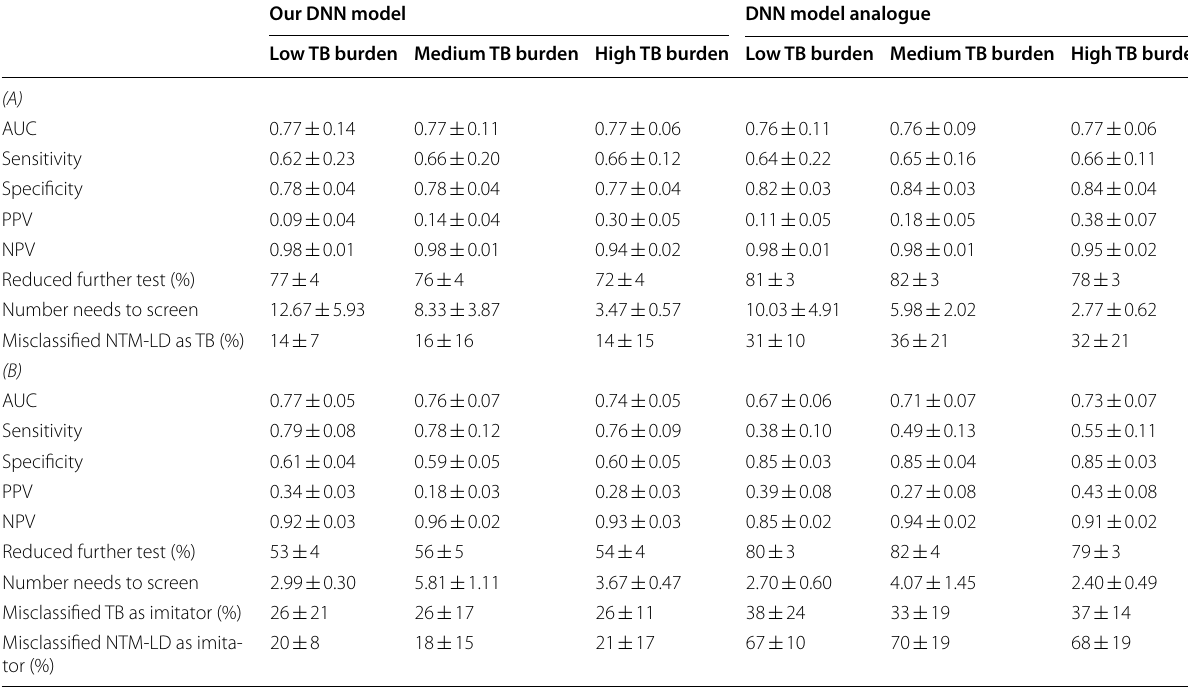
DNN, deep neural network; TB, tuberculosis; AUC, area under the receiver operating characteristic curve; PPV, positive predictive value; NPV, negative predictive value; NTM-LD, nontuberculous mycobacterial lung